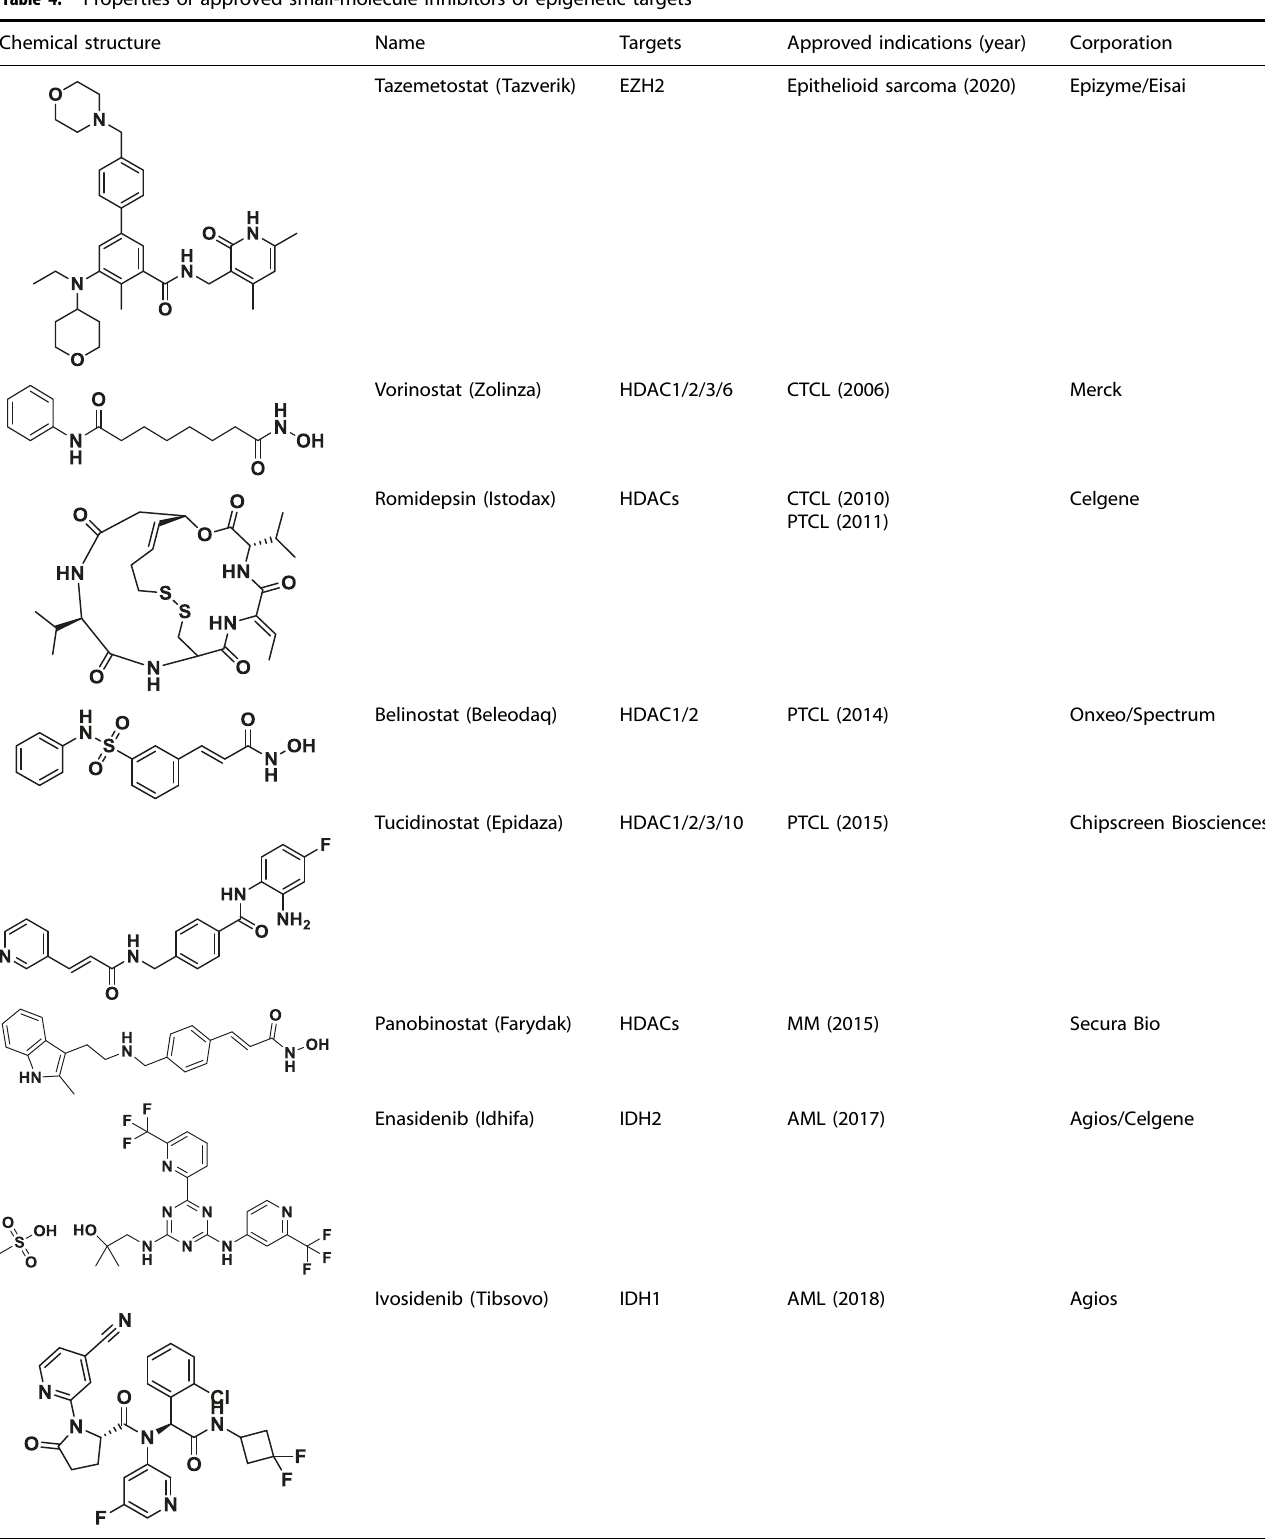
Table 4. Properties of approved small-molecule inhibitors of epigenetic targets Chemical